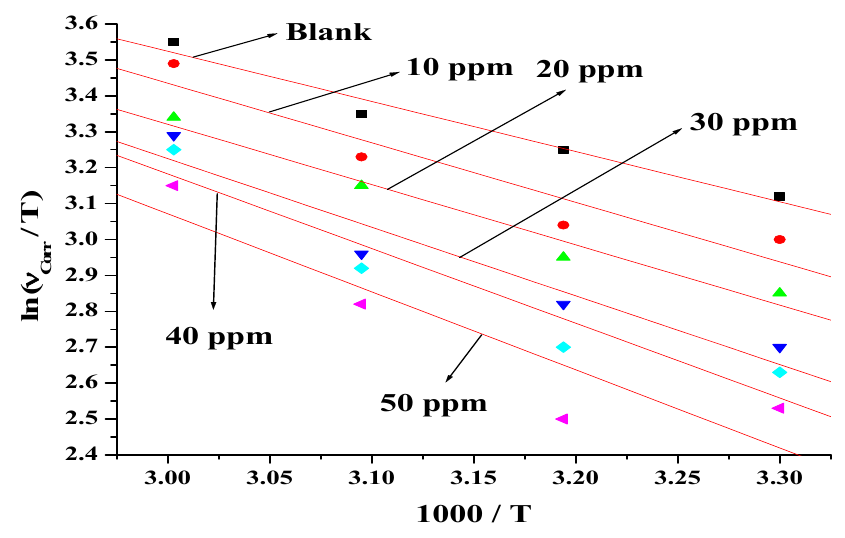
Figure 12. Arrhenius plot of soft-cast steel without and with the addition of various concentrations of olmesartan in 1 mol dm − 3 of HCl at temperatures ranging from 303 K to 333 K. Table 6. Activation parameters for steel surfaces in the absence and presence of various concentrations of olmesartan in 1 mol dm − 3 HCl at temperatures ranging from 303 K to 333 K. Concentration of Olmesartan (ppm) E a * (kJ/mol) Blank